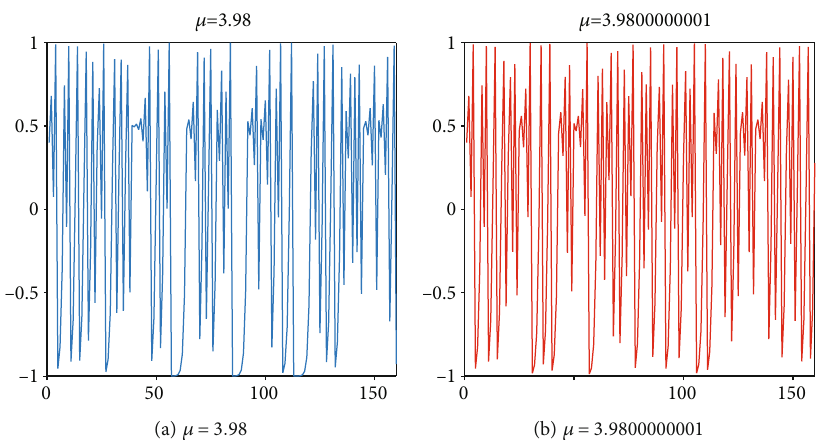
Figure 1: The sequence distribution diagram generated by 100 iterations of the system.